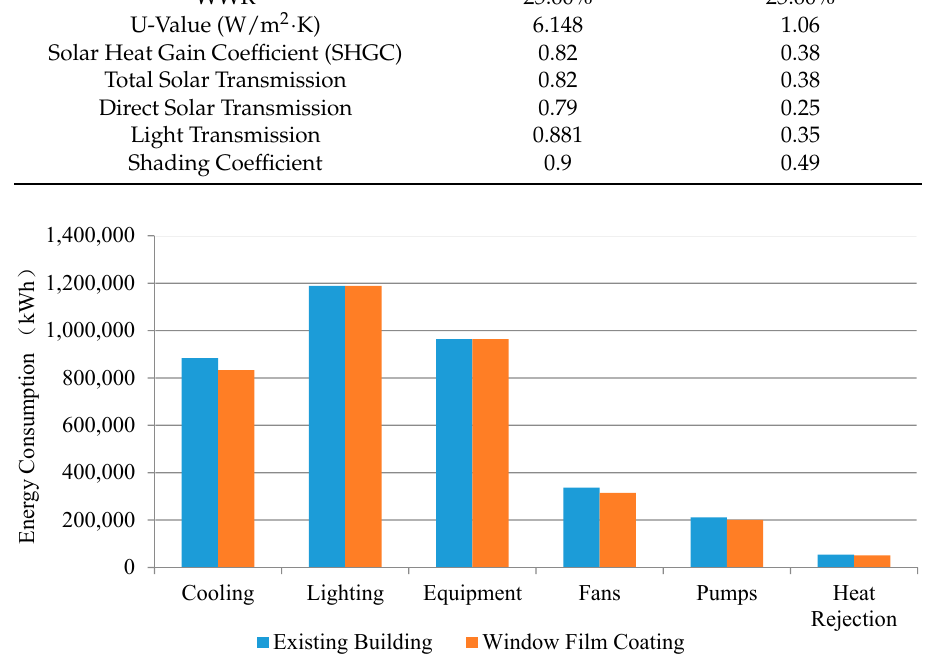
Figure 6. Annual energy consumptions before and after the windows coating.